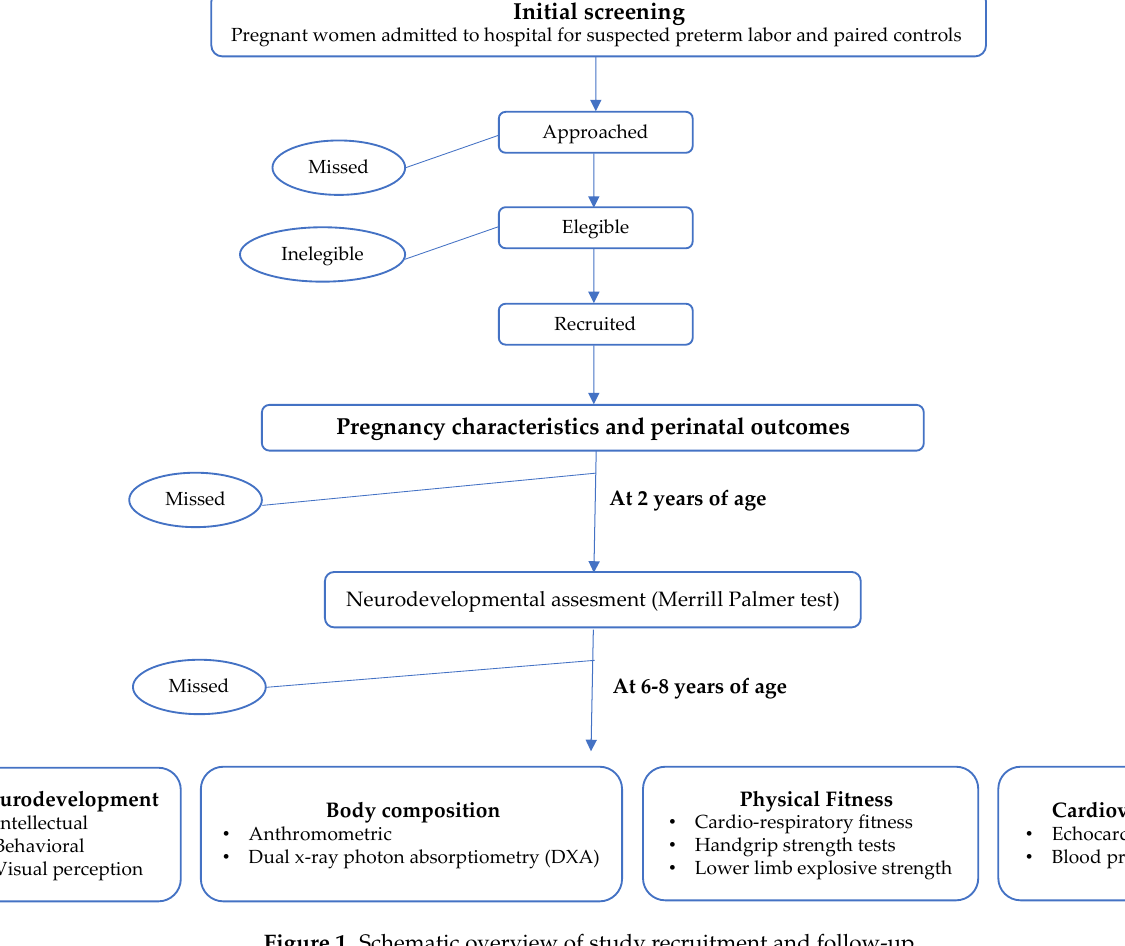
Figure 1. Schematic overview of study recruitment and follow-up.